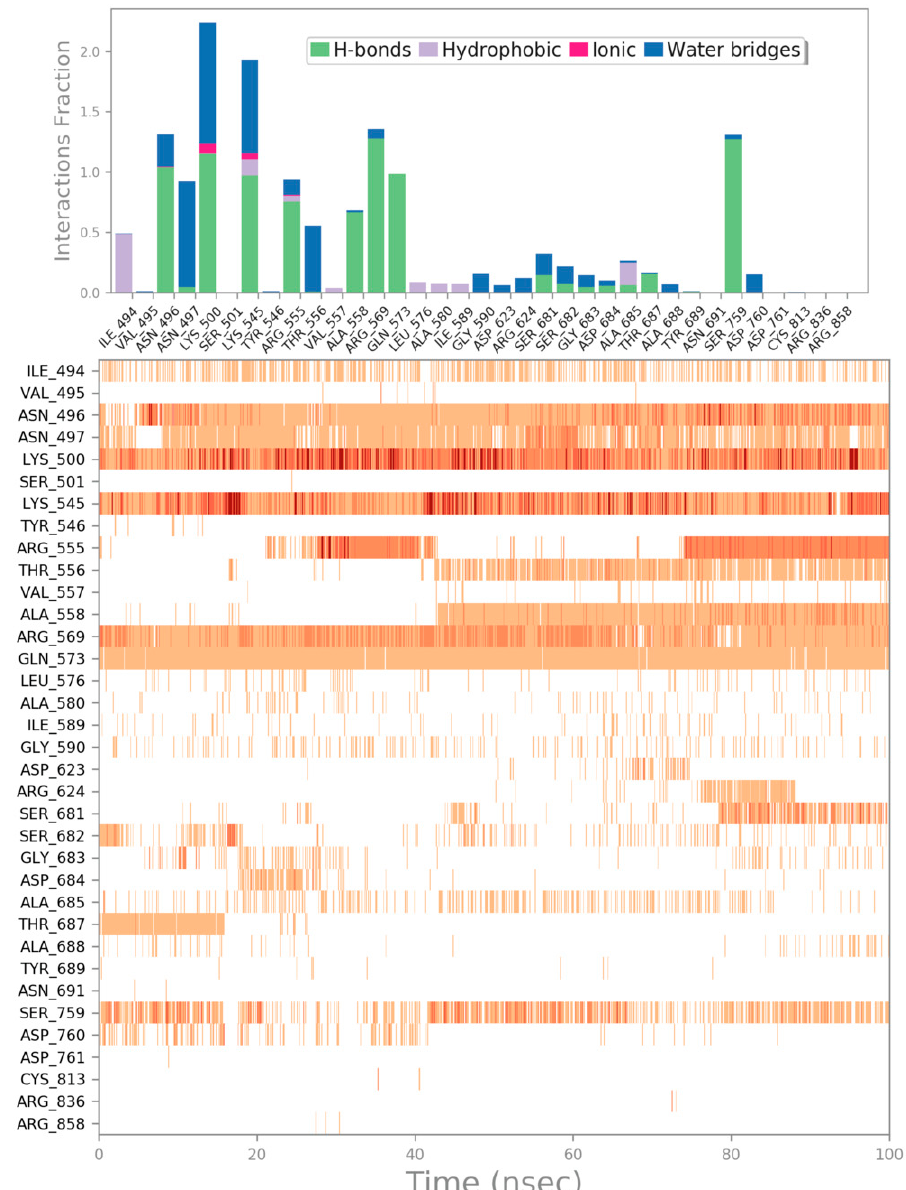
Figure 4. Compound 1 monitored during the simulation. The contacts can be grouped by type and summarized, as shown in the plots. Grouping protein–ligand interactions into four types: H-bonds (green), hydrophobic (grey), ionic (magenta), and water bridges (blue). The second graph of the picture displays a timeline representation of the contacts. Some residues make more than one specific contact with the ligand, which is represented by a darker shade of orange.